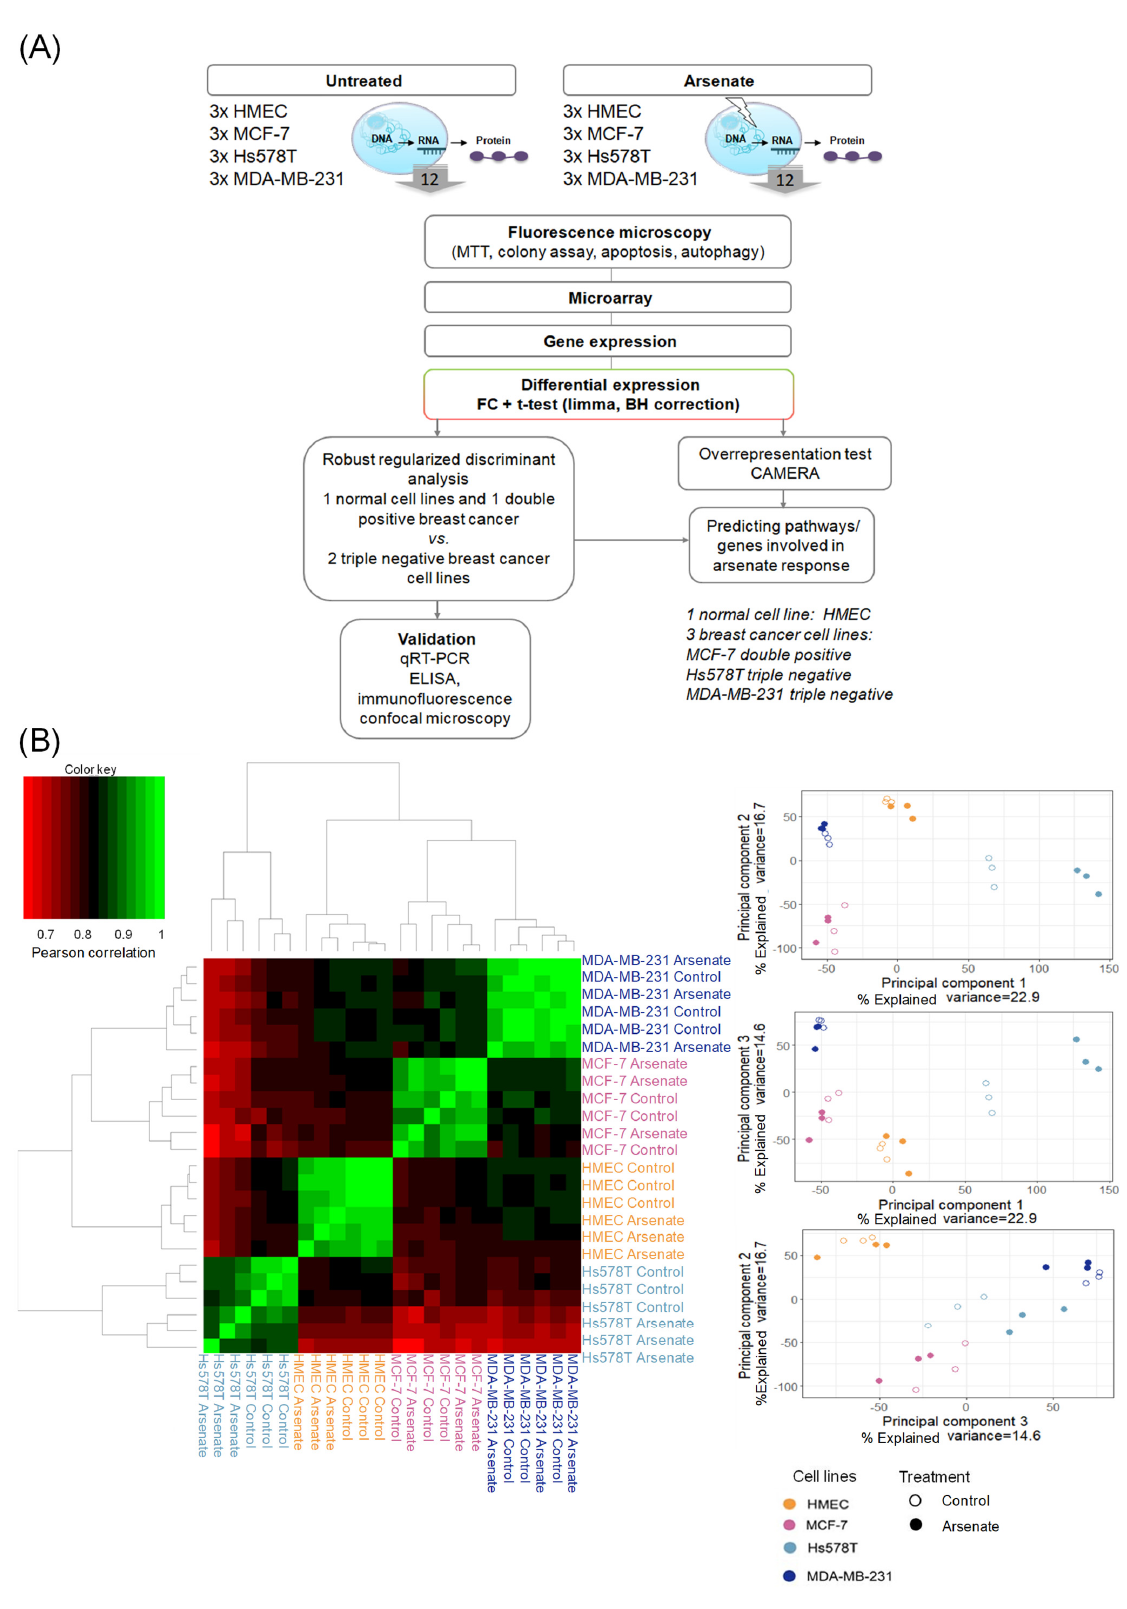
Figure 4. ( A ) Workflow of this study. First, we started with phenotypic readouts of different methods from the control (HMEC) and the three different breast cancer cell lines (MCF-7, Hs578T and MDA-MB-231) with and without arsenate treatment. Next, microarray data were collected from three replicates each of the four cell lines in each condition. Subsequently, we determined differentially expressed genes using fold change (FC) and the False Discovery Rate